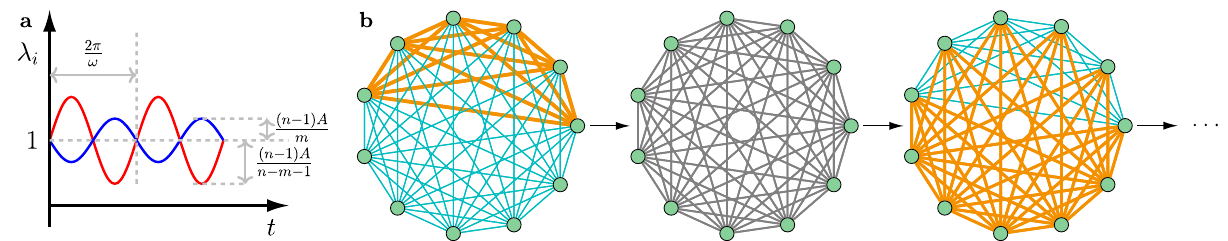
Fig. 2 Designing temporal networks that synchronize better than optimal static networks. a Evolution of the nonzero Laplacian eigenvalues described in Eq. (5), which are split into two degenerate groups. b Temporal network constructed from the Laplacian eigenvalues in a . The weight of each edge is represented by its thickness. In addition, edges whose weight is larger than 1 n are colored orange, whereas those with weight less than 1 n are colored cyan. For this network diagram, we set n = 11 and m = 5, and the corresponding weighted adjacency matrix is given by Eq. (9). Visually, we can see that different parts of the network are being strengthened in an